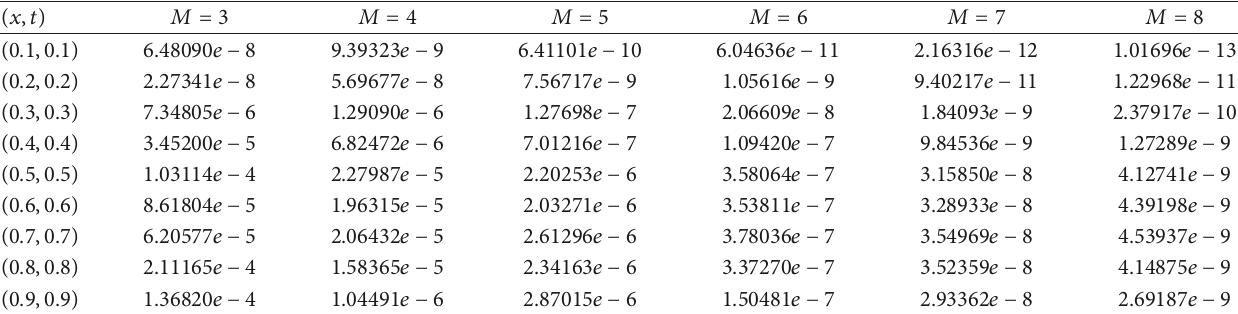
Table 10: The absolute errors for Example 5 at some different points with 𝑘 = 2 and 𝑀 = 3 to 8